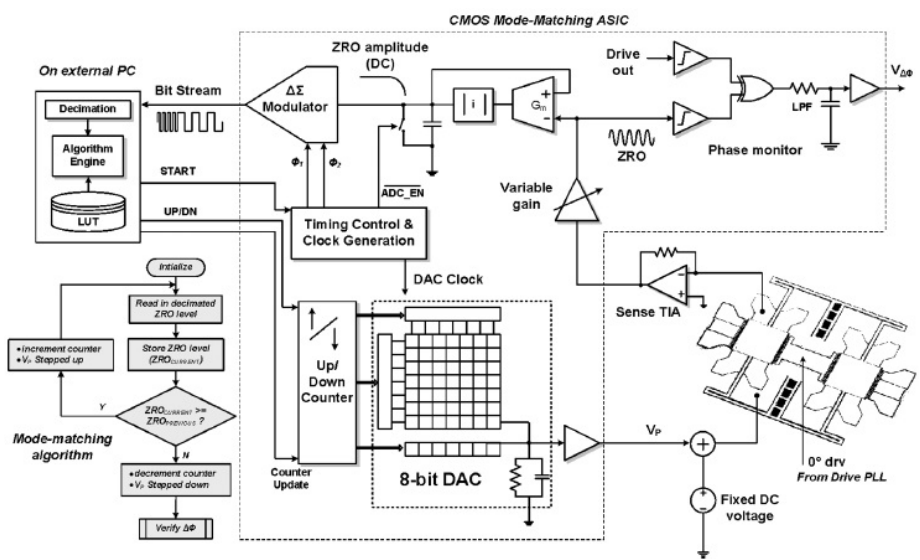
Figure 38. Georgia Tech mode matching